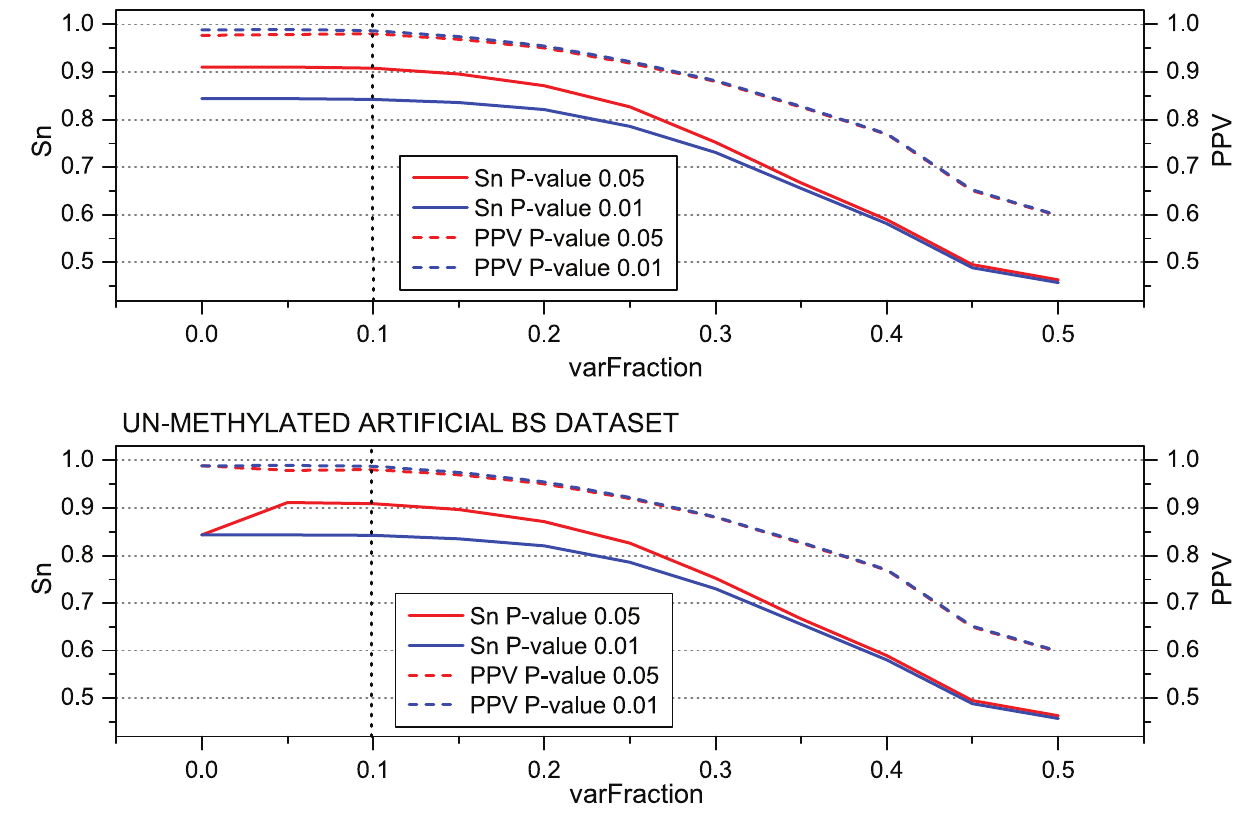
Figure 4. MethylExtract SNV calling as a function of the minimum relative nucleotide frequency (‘varFraction’). The figures show the sensitivity (Sn) and the positive predictive value (PPV) for SNV detection using two different p-value thresholds. The graphs are based on the methylated (top) and un-methylated (bottom) artificial bisulfite datasets at a mean 20× read